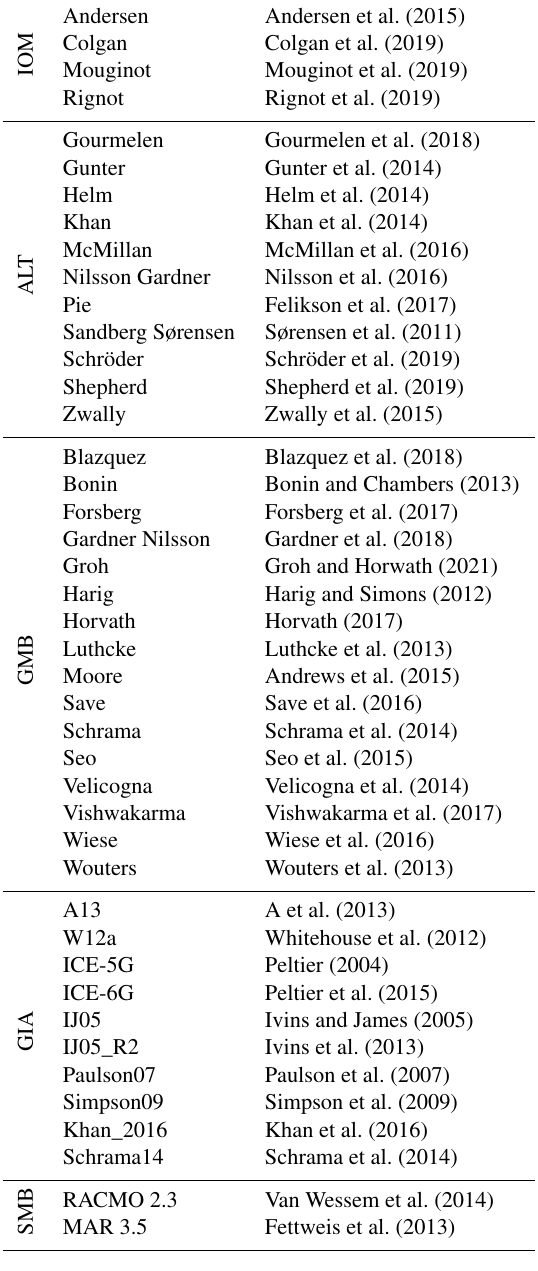
Table A1. References of the datasets, methods, GIA, and SMB models employed by participants of the input–output (IOM), altime- try (ALT), and gravimetry (GMB) experiment